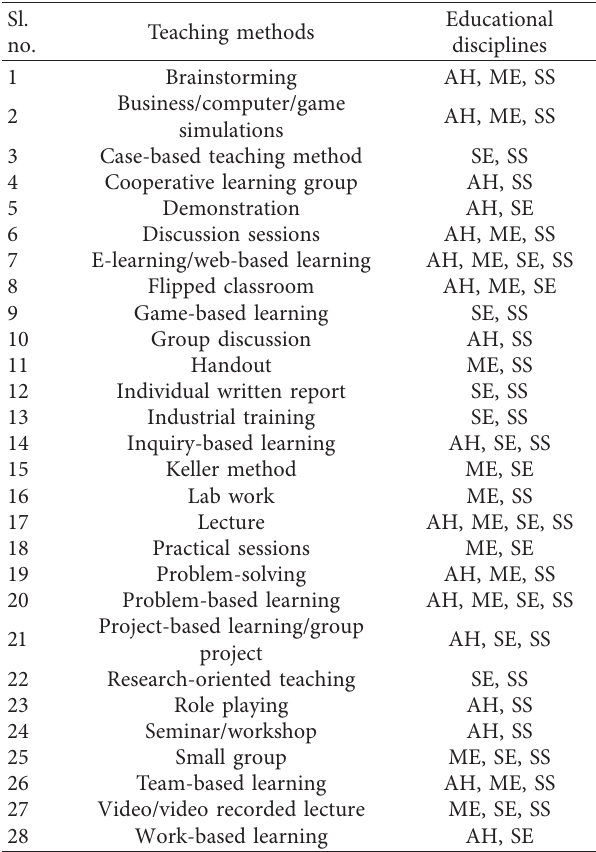
Table 3: TMs across the disciplines. Sl.